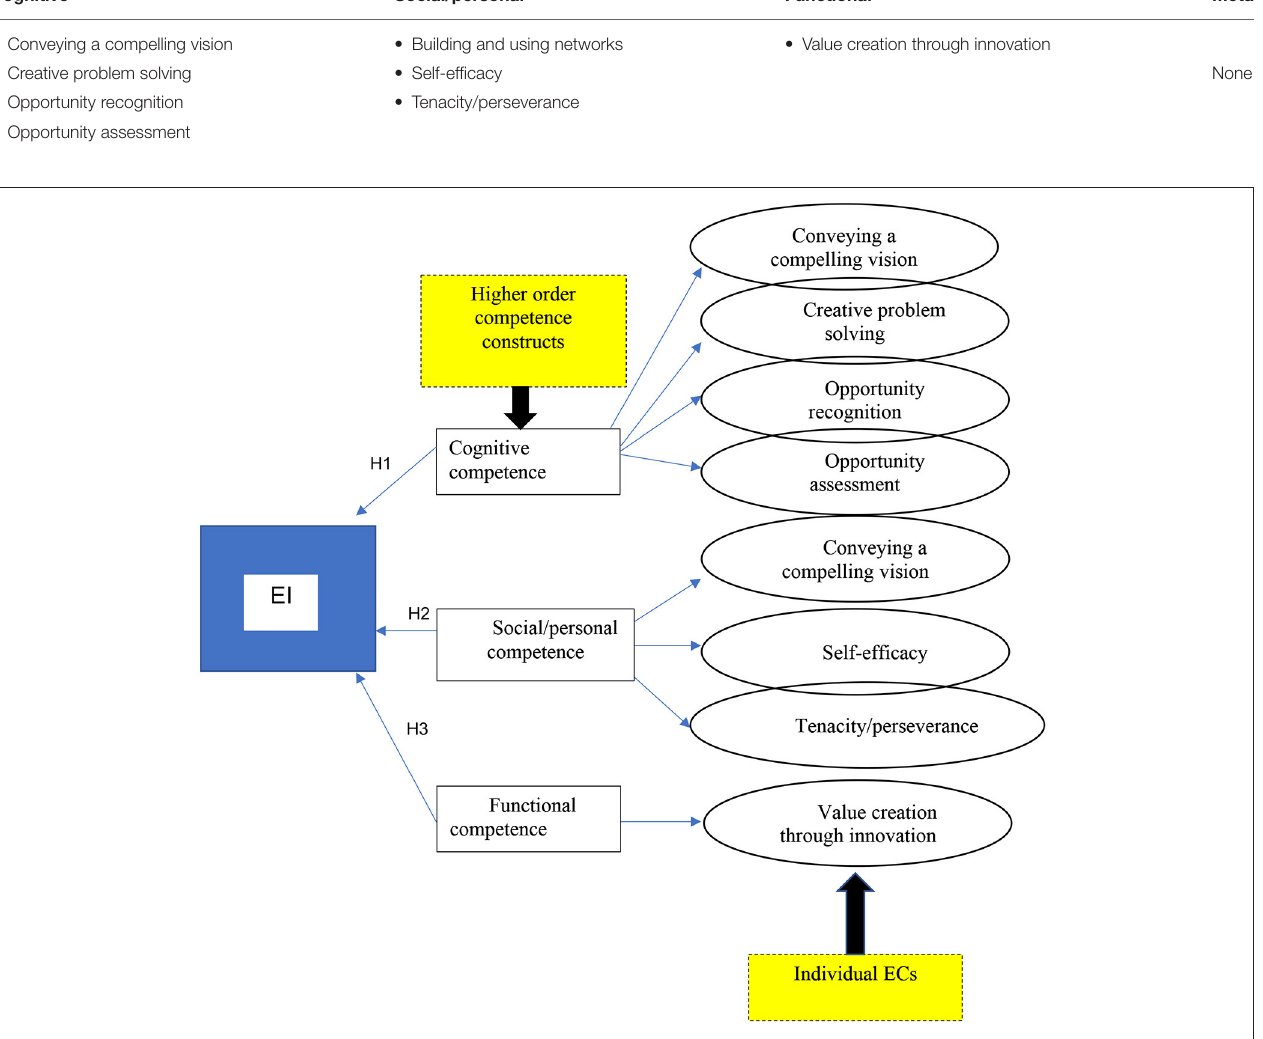
TABLE 1 | Grouping entrepreneurial competencies (ECs) into higher-order competence categories. Cognitive